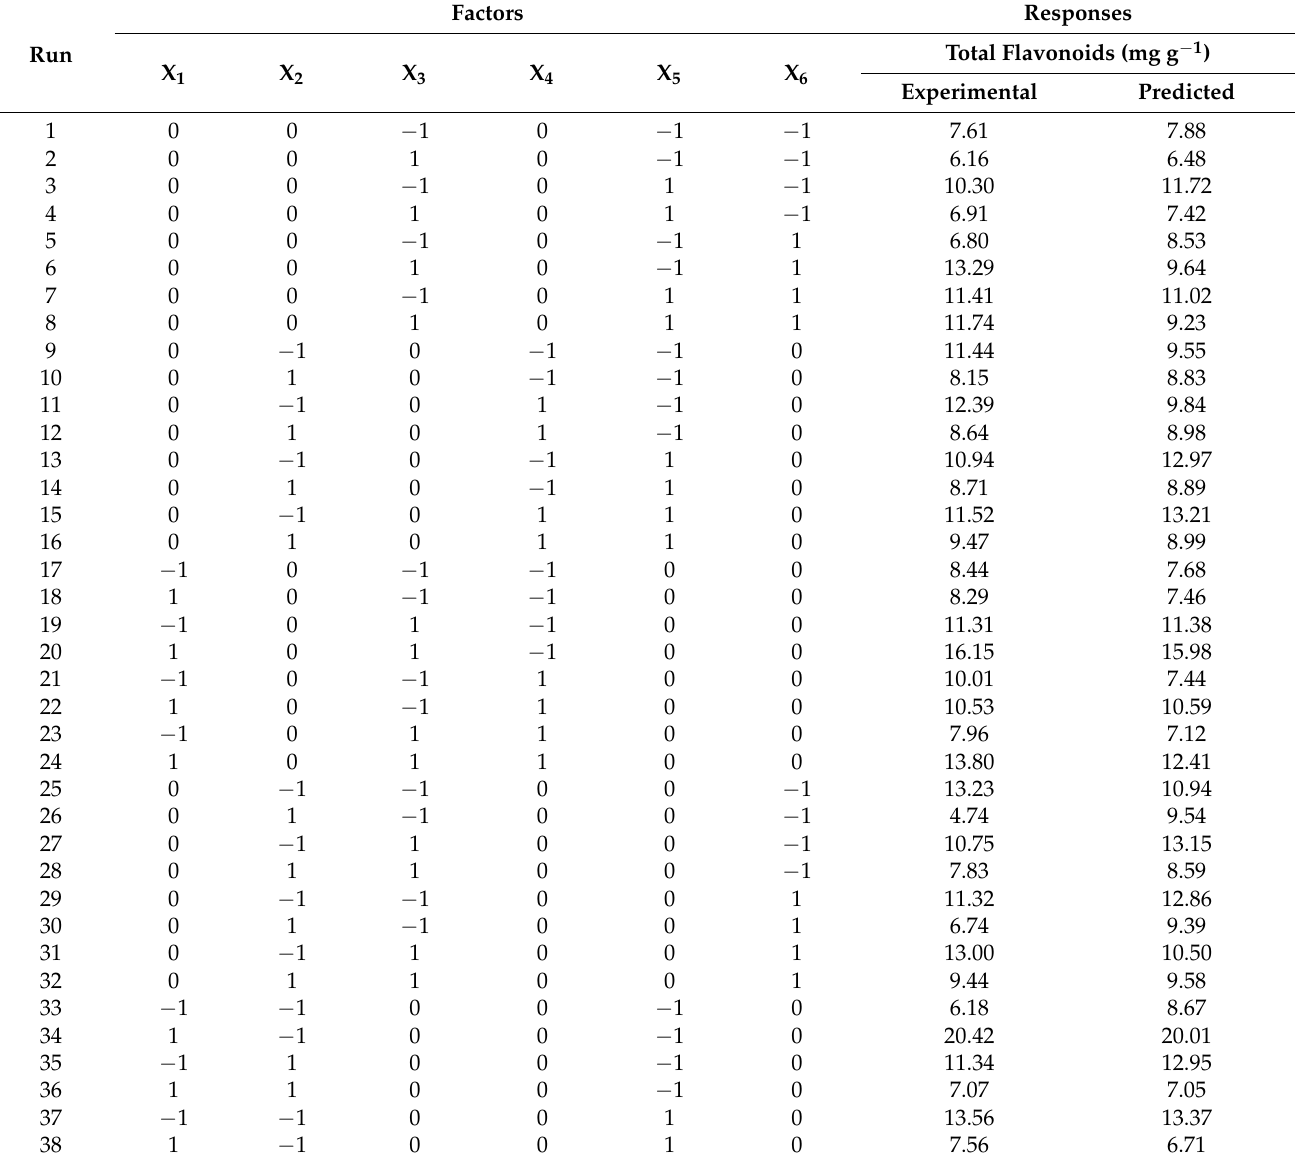
Table 2. Conditions of the Box–Behnken design for the six variables, including experimental and predicted